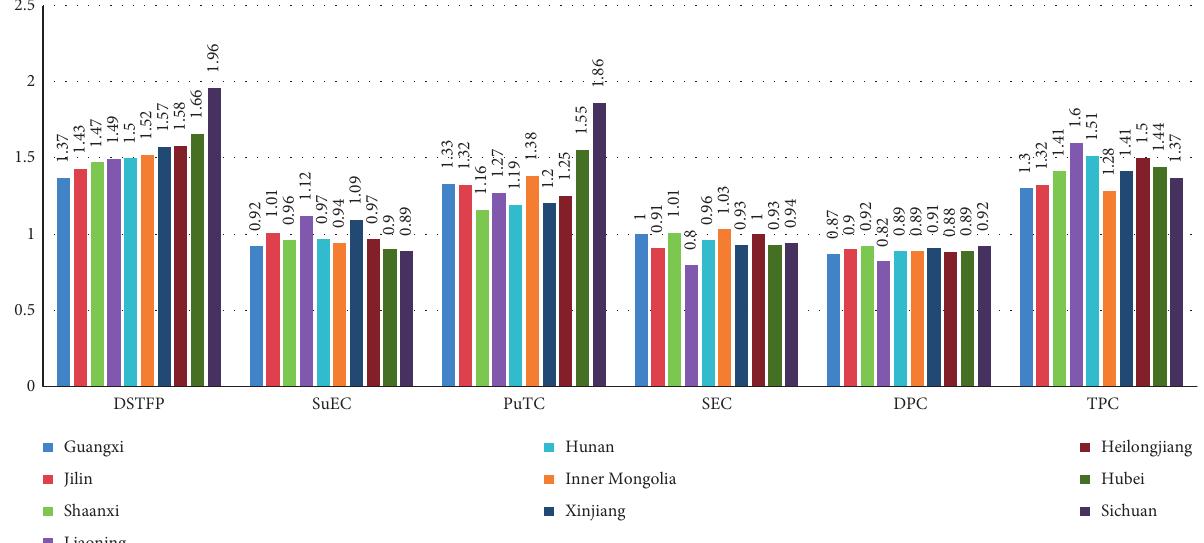
Figure 6: Decomposed efficiency indexes of